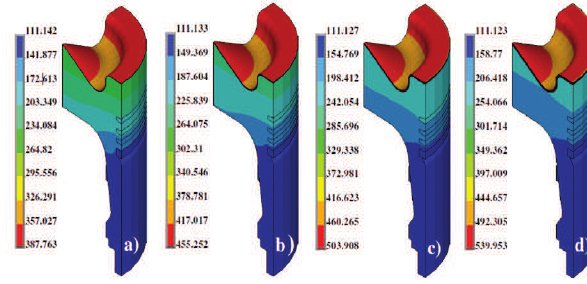
Fig. 7. Distribution of temperatures of the upper section of the coating for varied coating thickness: a) 0.4 mm, b) 0.8 mm, c) 1.2 mm, d) 1.6 mm [3]